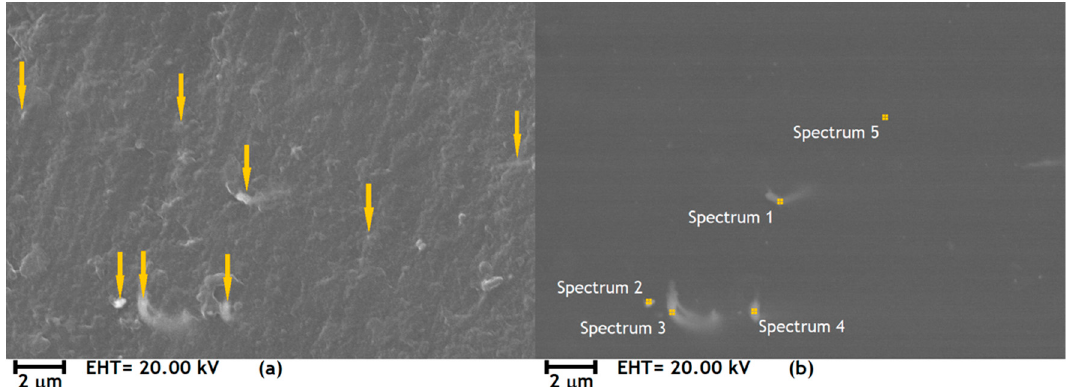
Figure 2. SEM images on the surface of a CuNi NW-loaded substrate; ( a ) secondary electron micrograph, with yellow arrows indicating the position of the CuNi NWs aggregates; and ( b ) backscattered electron micrograph, which shows the regions analyzed by EDS.